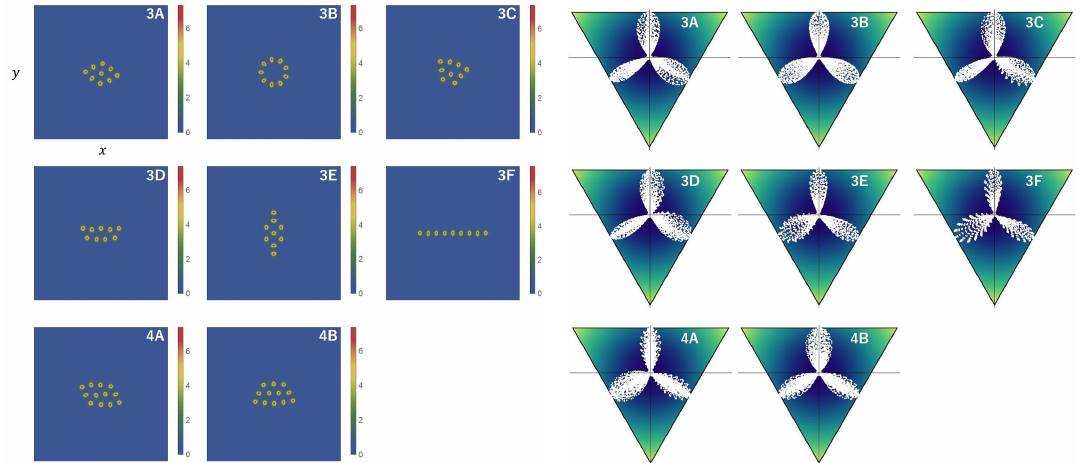
Figure 4 . The energy density (left) and toric diagram (right) of the solutions with Q = 3 and Q = 4 .